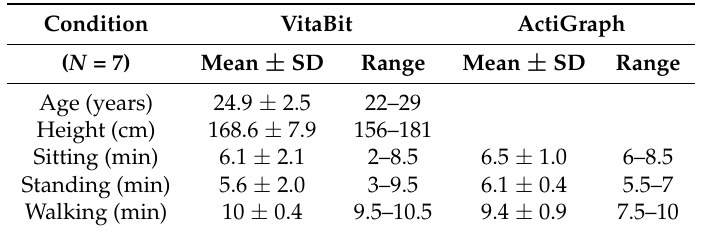
Table A1. Sub-study: Description of population and activity